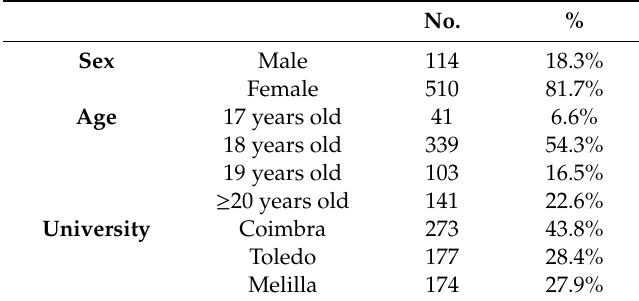
Table 1. Sociodemographic characteristics of the study